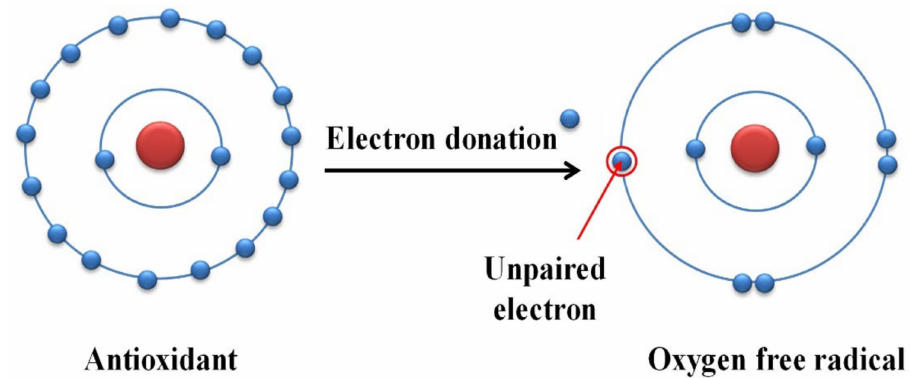
Figure 2. Mode of action of melanin as an